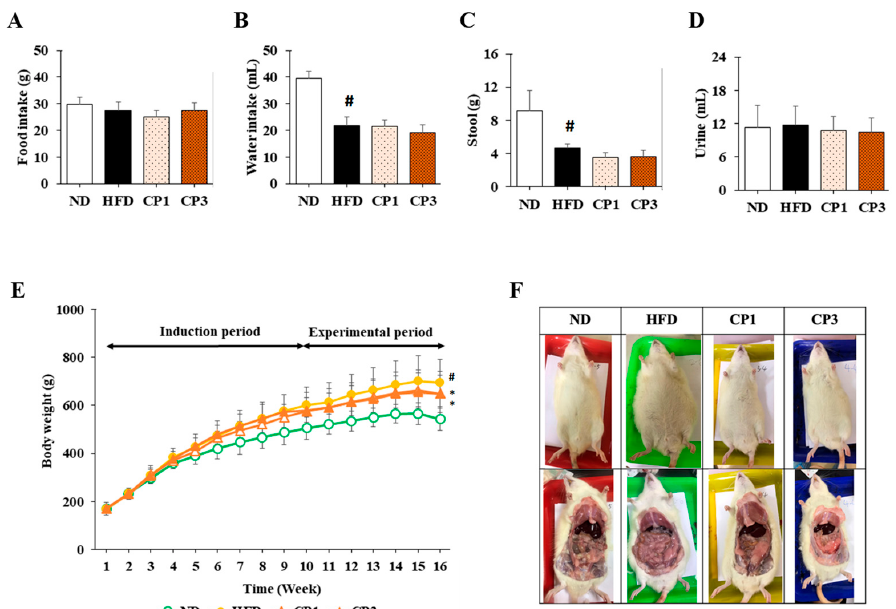
Figure 2. Week-average of ( A ) feed intake, ( B ) water intake, ( C ) stool weight, ( D ) urine volume, ( E ) body weight, and ( F ) representative photos of appearance and abdominal organ of rats. The rats in each group were treated as described in the Materials and Methods section, and the feed intake, water intake, stool weight, urine volume, and body weight of each rat were measured and recorded weekly. After 16-week treatment, the rats were sacrificed, and the photos of appearance and abdominal organs of rats were taken individually. Results are expressed as mean ± S.D. for each group of rats ( n = 6). # p < 0.05 compared with the ND group; * p < 0.05 compared with the HFD group.